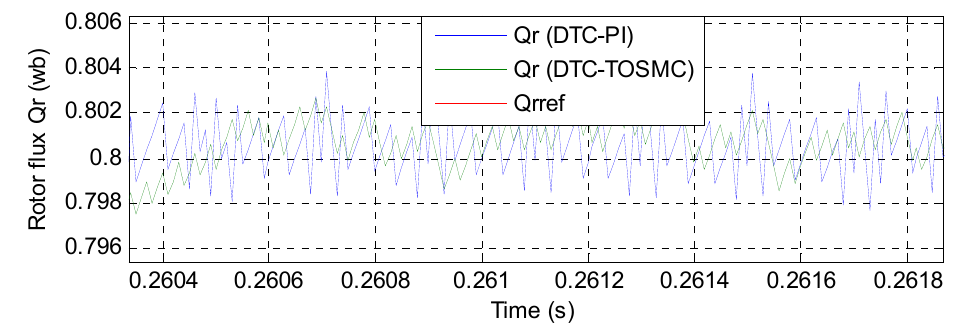
Figure 11. Zoom in the torque.